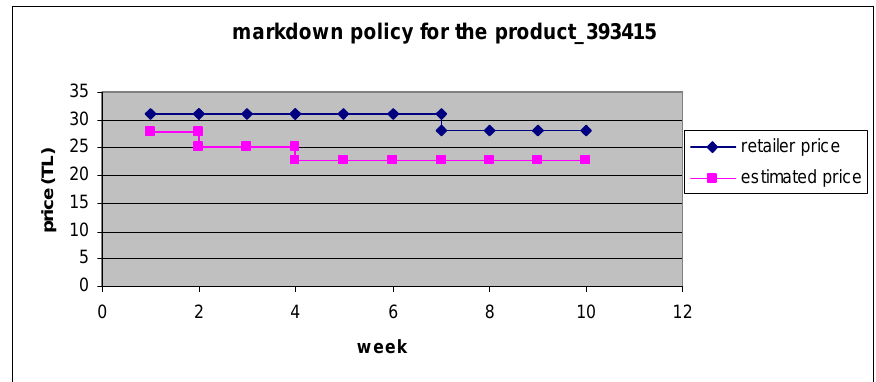
Fig. 8. Comparison between the retailer and estimated prices